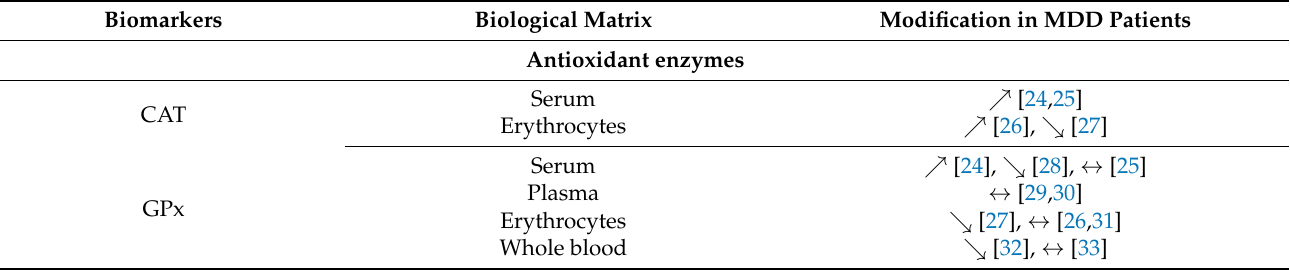
Table 1. Peripheral biomarkers of oxidative stress in unspecified MDD patients compared to